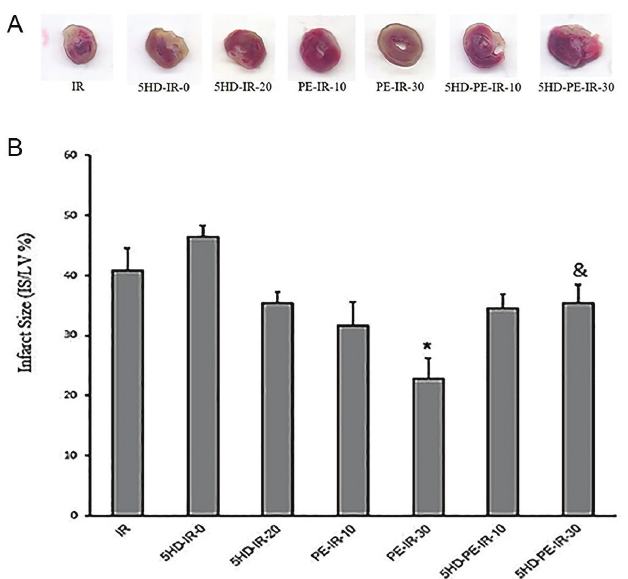
FIGURE 3 - A - The original pictures of TTC staining heart slices. 5HD, 5 hydroxydecanoate. B - The ratio of infarct size to total left ventricular area (IS/LV%) in ischemia/reperfusion (IR), 5HD perfused at onset of regional ischemia (5HD-IR-0), 5HD perfused 20 min after regional ischemia (5HD-IR-20), phenylephrine-early perconditioning 10 min after ischemia (PE-IR-10), phenylephrine-late perconditioning 30 min after ischemia (PE-IR-30), 5HD-phenylephrine Early perconditioning (5HD-PE-IR-10), 5HD-phenylephrine-late perconditioning (5HD-PE-IR-30) groups. Data are presented as Mean ±S.E.M. Significant difference with IR group (P<0.05) * . Significant difference with PE-IR-30 group (P<0.05) & .